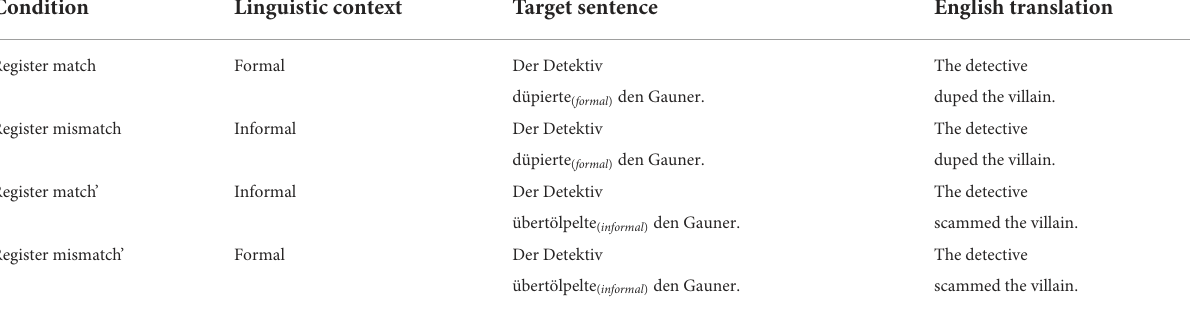
TABLE 4 Project C03: Eye-tracking reading